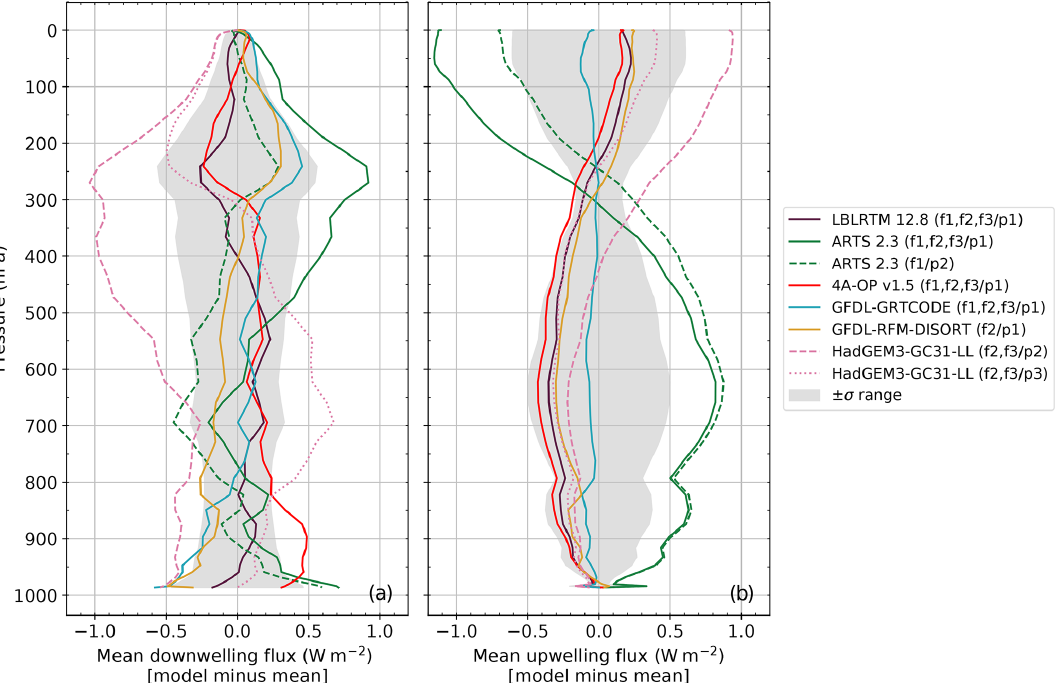
Figure 2. Comparison of net flux profiles between line-by-line models participating in RFMIP-IRF. Panels (a) and (b) respectively show the distance to the mean of the mean downwelling and upwelling flux profiles for every pair of model and physics variant. The averaging is first performed on the 100 atmospheric profiles using provided weights and then on the 18 perturbations (uniformly weighted). Finally, for every pair of model and physics variant, all available forcing variants are averaged. The ± 1 standard deviation range ( ± σ ) is represented by the gray shaded area. Table 3. Means and standard deviations of OLR differences (model minus 4A/OP) in Wm − 2